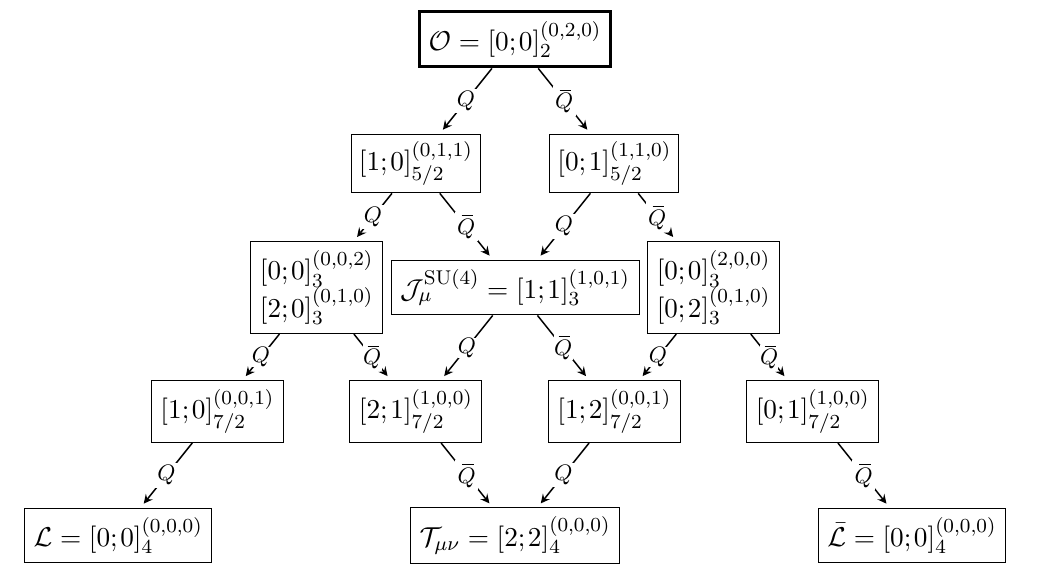
¯ , where [ ‘, ¯ ‘ ] ‘ ] ( p 1 ,p 2 ,p 3 ) ∆ ) are the SU(4) Dynkin labels and ∆ represents 1 , p 2 , p 3 R